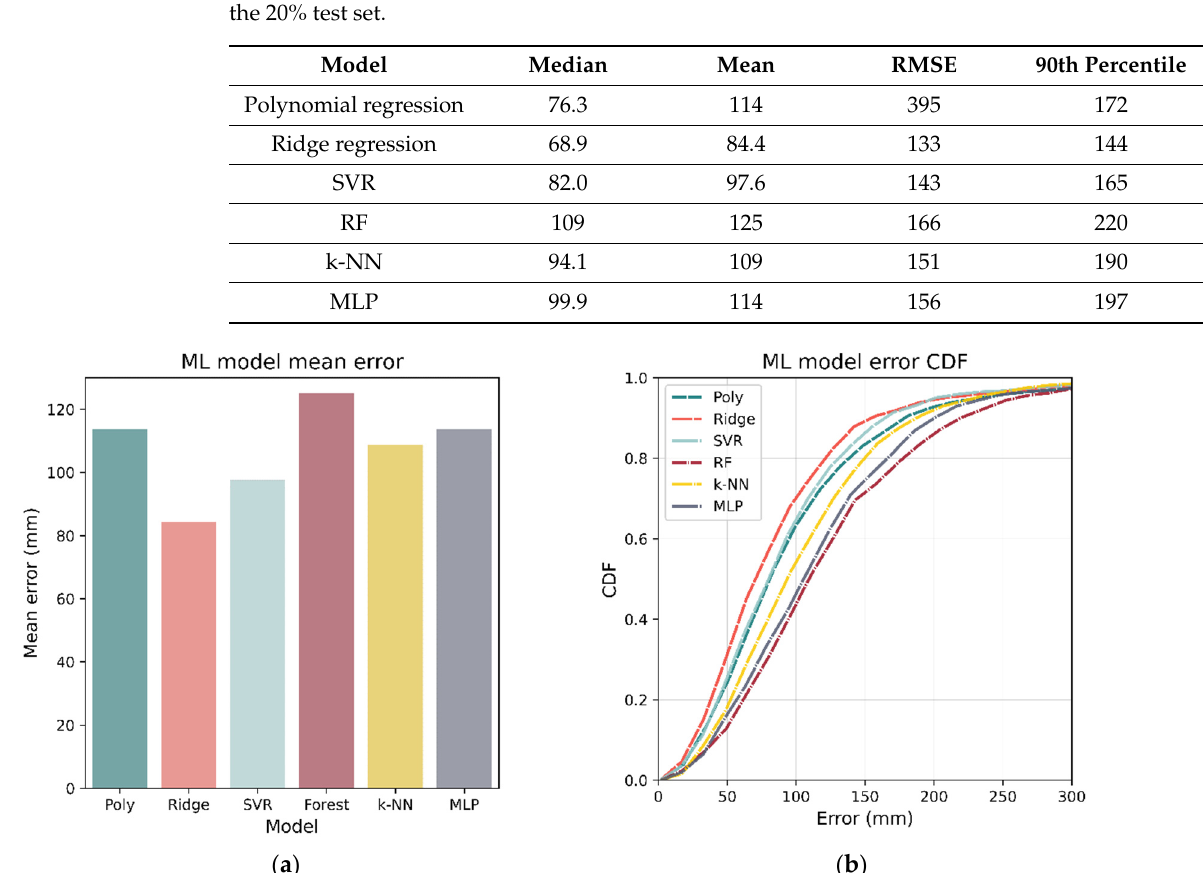
Figure 19. Mean and CDF for errors of tuned models trained on the entire 80% training set. Errors were evaluated using the 20% test set, and it can be seen, in both ( a ) and ( b ), that ridge regression has the best performance, with RF being the worst.